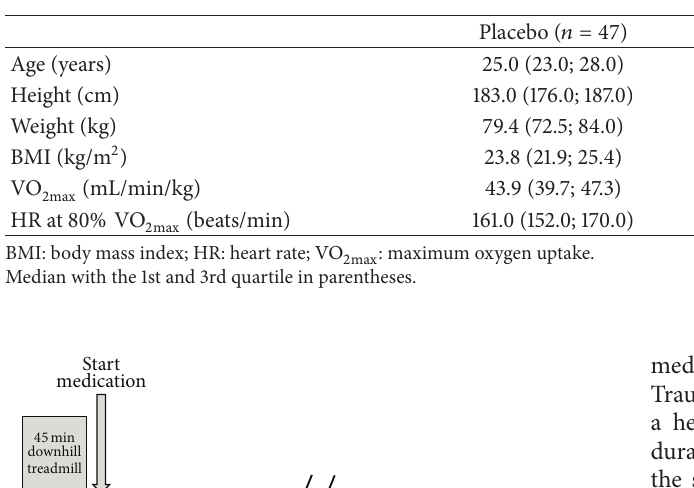
Table 1: Subject characteristics of placebo and Tr14 group (the median with the 1st and 3rd quartile is shown in parentheses).